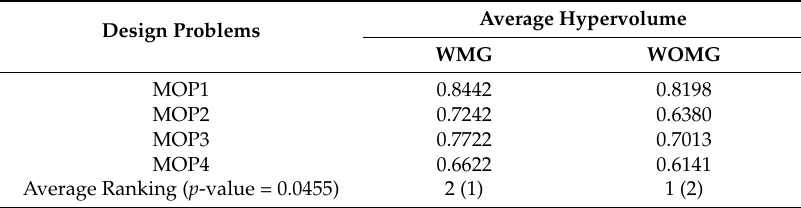
Table 3. Performance comparison of each MOP with and without MG for all